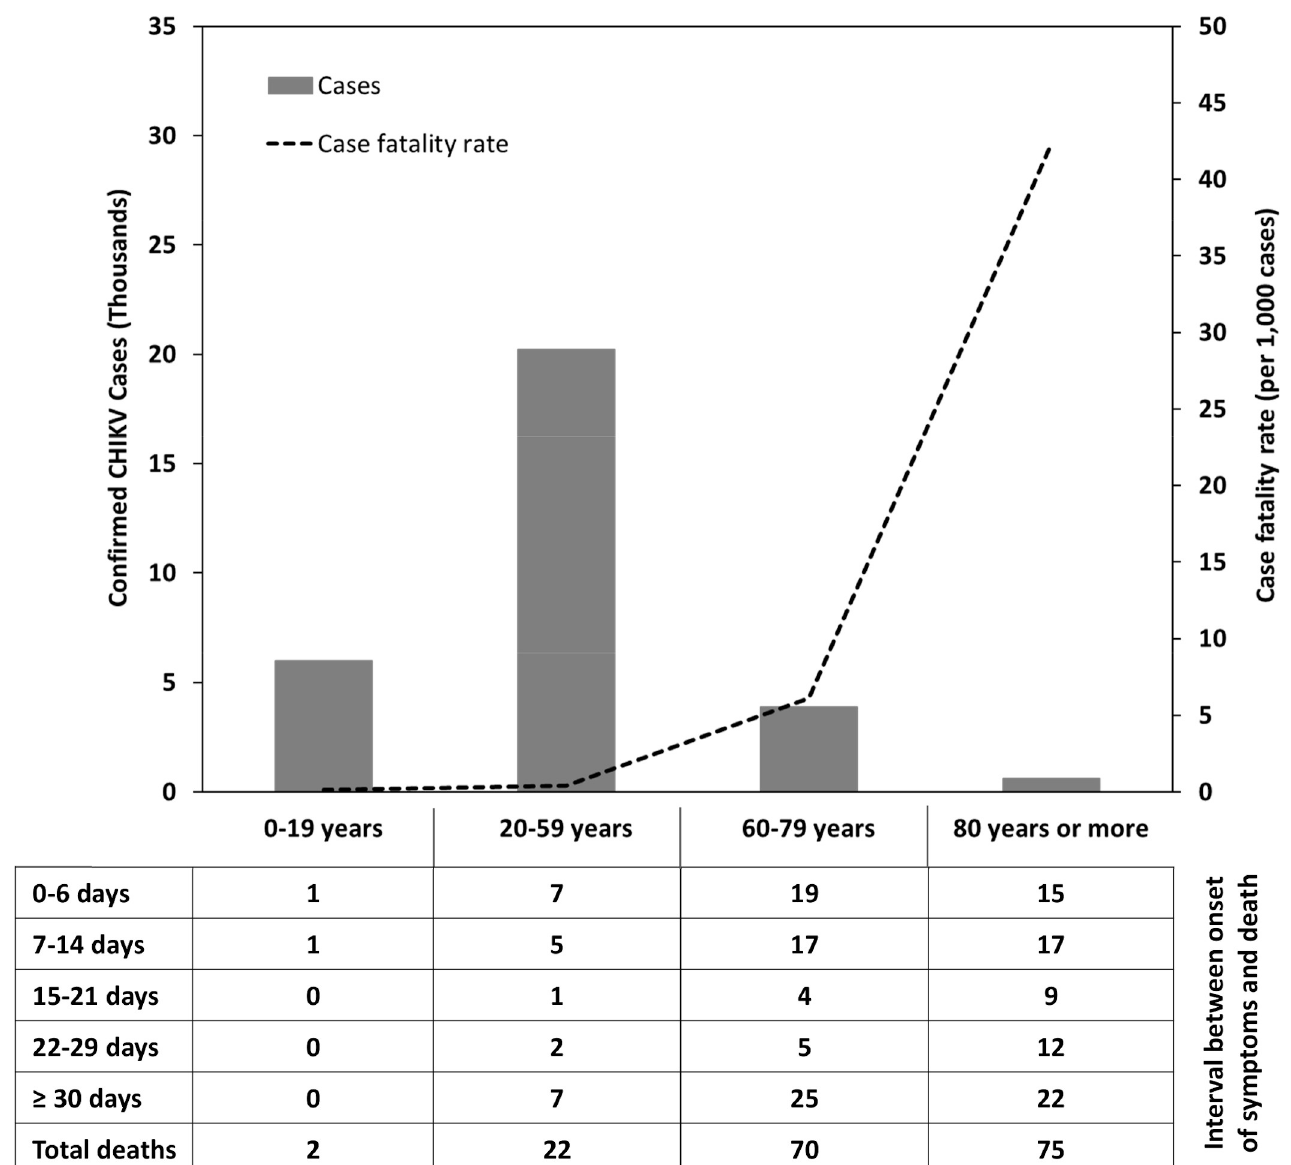
Fig 1. Confirmed chikungunya cases (N = 80,153), case fatality rates (per 1,000 cases), and confirmed chikungunya deaths (N = 169) by age groups and interval between onset of symptoms and death (days) in Fortaleza, Brazil (2016–2017).